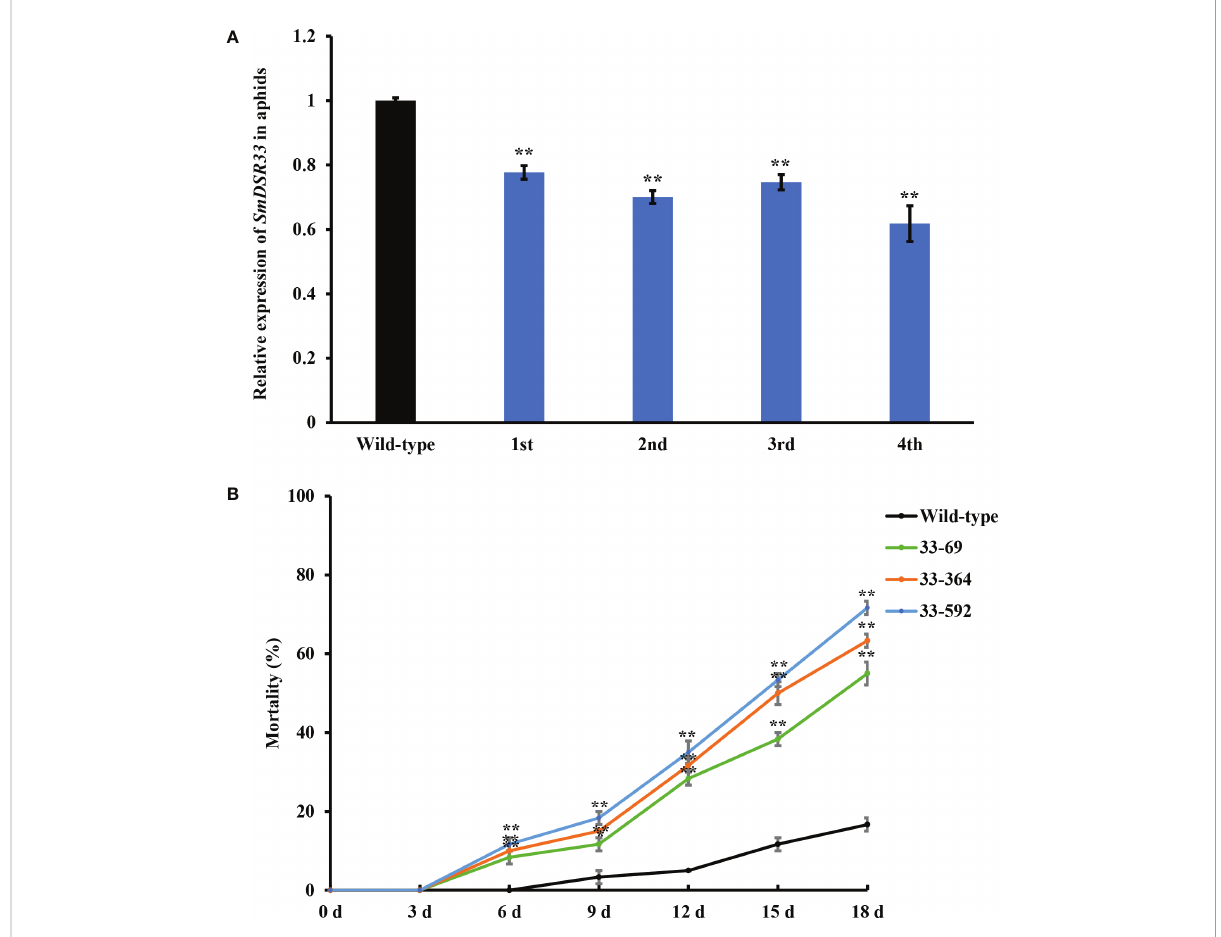
FIGURE 5 Transgenerational effect of SmDSR33 silencing. The one-day-old newborn nymphs of aphids feeding on transgenic wheat lines were transferred to fresh wild-type wheat plants and subsequently allowed to reproduce on wild-type. (A) The SmDSR33 transcript levels of adult aphids were determined in fourth successive aphid generations. (B) The mortality of the fi rst generation of the offspring of aphids fed on transgenic lines at different time points after being switched to wild-type plants. Values and bars represent the mean ± SEM (Student ’ s t -test, * P <0.05, ** P